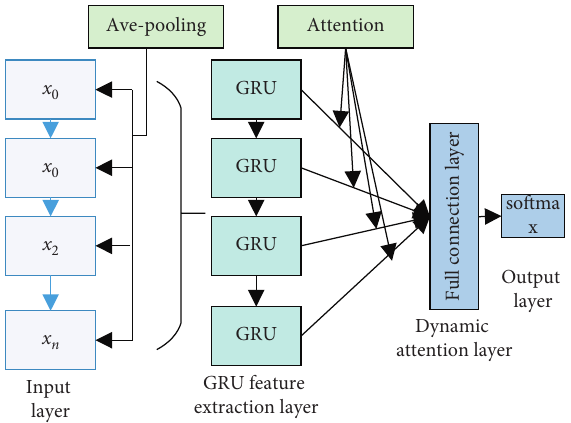
Figure 2: Structure of DAGRU